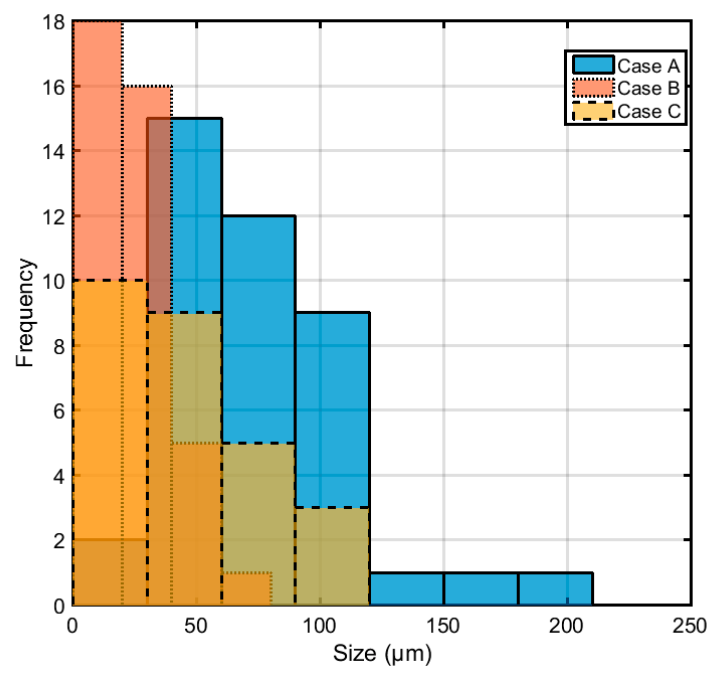
Figure 3. Histogram of the emulsions used for the experiments made at 10% water in fuel tank (Fresh) and Cases A, B, and C after the fuel equipment at different injection pressures of 500, 1000, and 1500 bar, respectively.